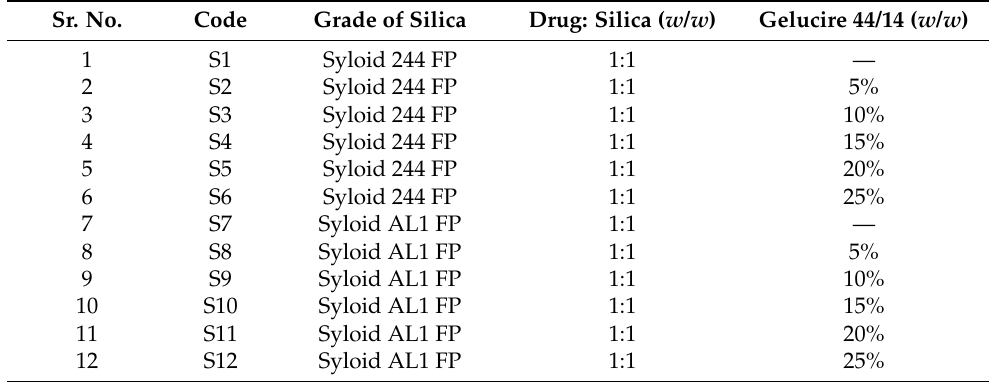
Table 1. Composition of binary and ternary solid dispersions. Sr. No.